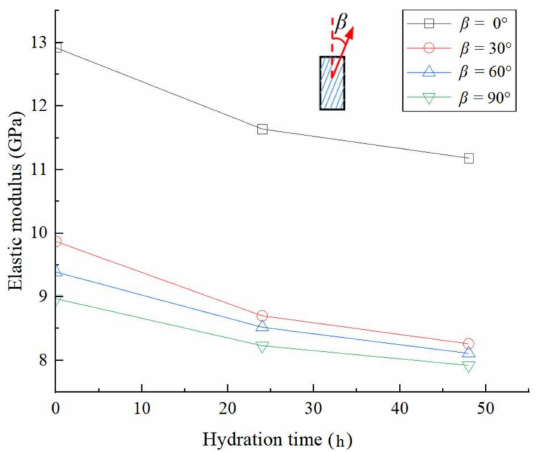
Figure 8. Elastic modulus of the lamellar shale samples under confining pressure of 15 MPa changed with hydration